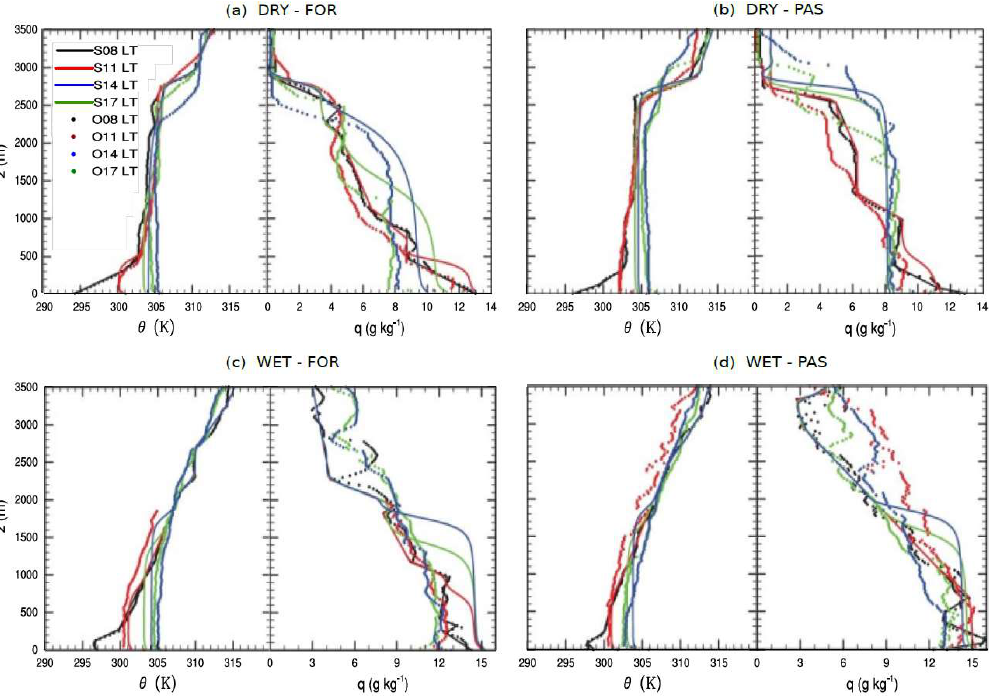
Figure 2. Vertical profiles of potential temperature ( θ ) and specific humidity (q) in the course of the day for: FOR ( a , c ); and PAS ( b , d ) sites, during: DRY ( a , b ); and WET ( c , d ). The LES profiles are domain- and time-averaged (solid lines, 10-min mean), while sensor data are shown by dots.